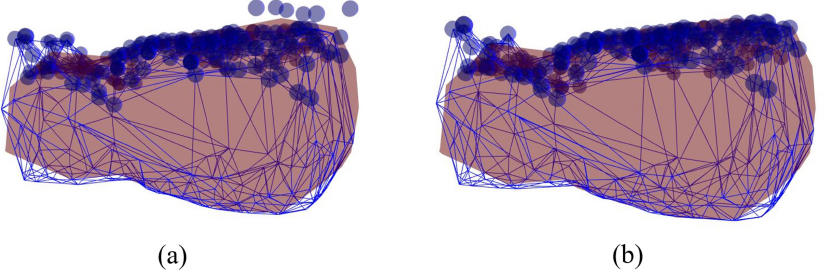
Figure 5. Feature points (blue points) on the low-resolution models (blue lines) that are mapped from ( a ) an initial frame to ( b ) an updated frame.